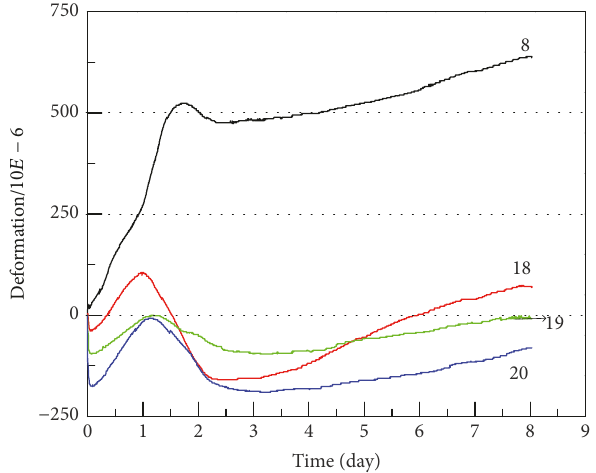
Figure 13: The autogenous shrinkage of references with SRA and SRA-SCA.